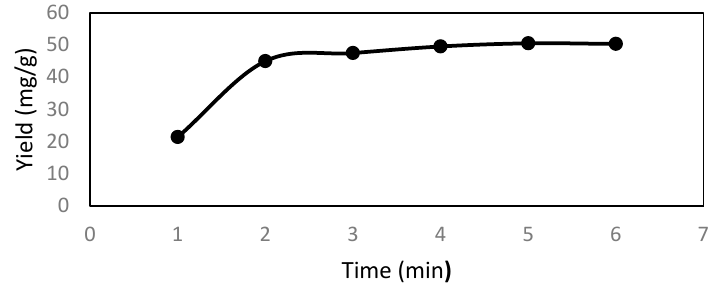
Figure 5. Extraction yield (mg / g) per time.